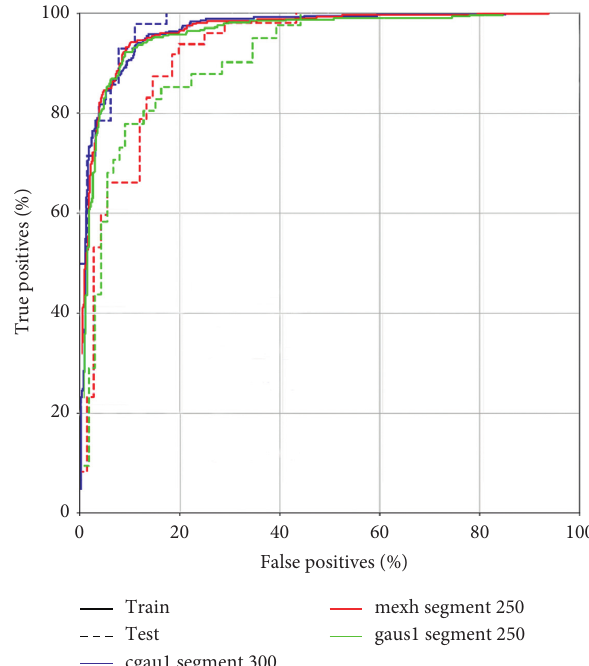
Figure 4: The receiver-operating characteristic curves of cgau1 and segment-300; gaus1 and segment-250; and mexh and segment-250 for prediction of blood pressure classification.